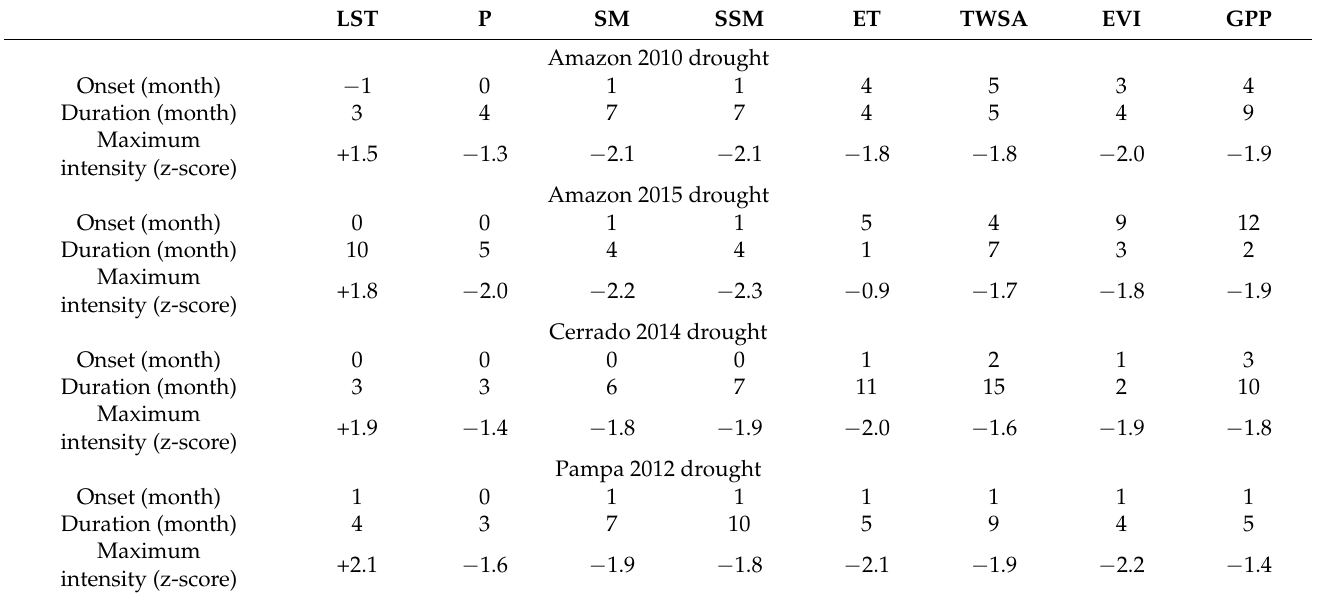
Table 3. Characteristics of drought events according to onset, duration, and maximum intensity for the 2010 and 2015 droughts in the Amazon, 2014 drought in the Cerrado, and 2012 drought in the Pampa biome. The onset was characterized relative to the precipitation